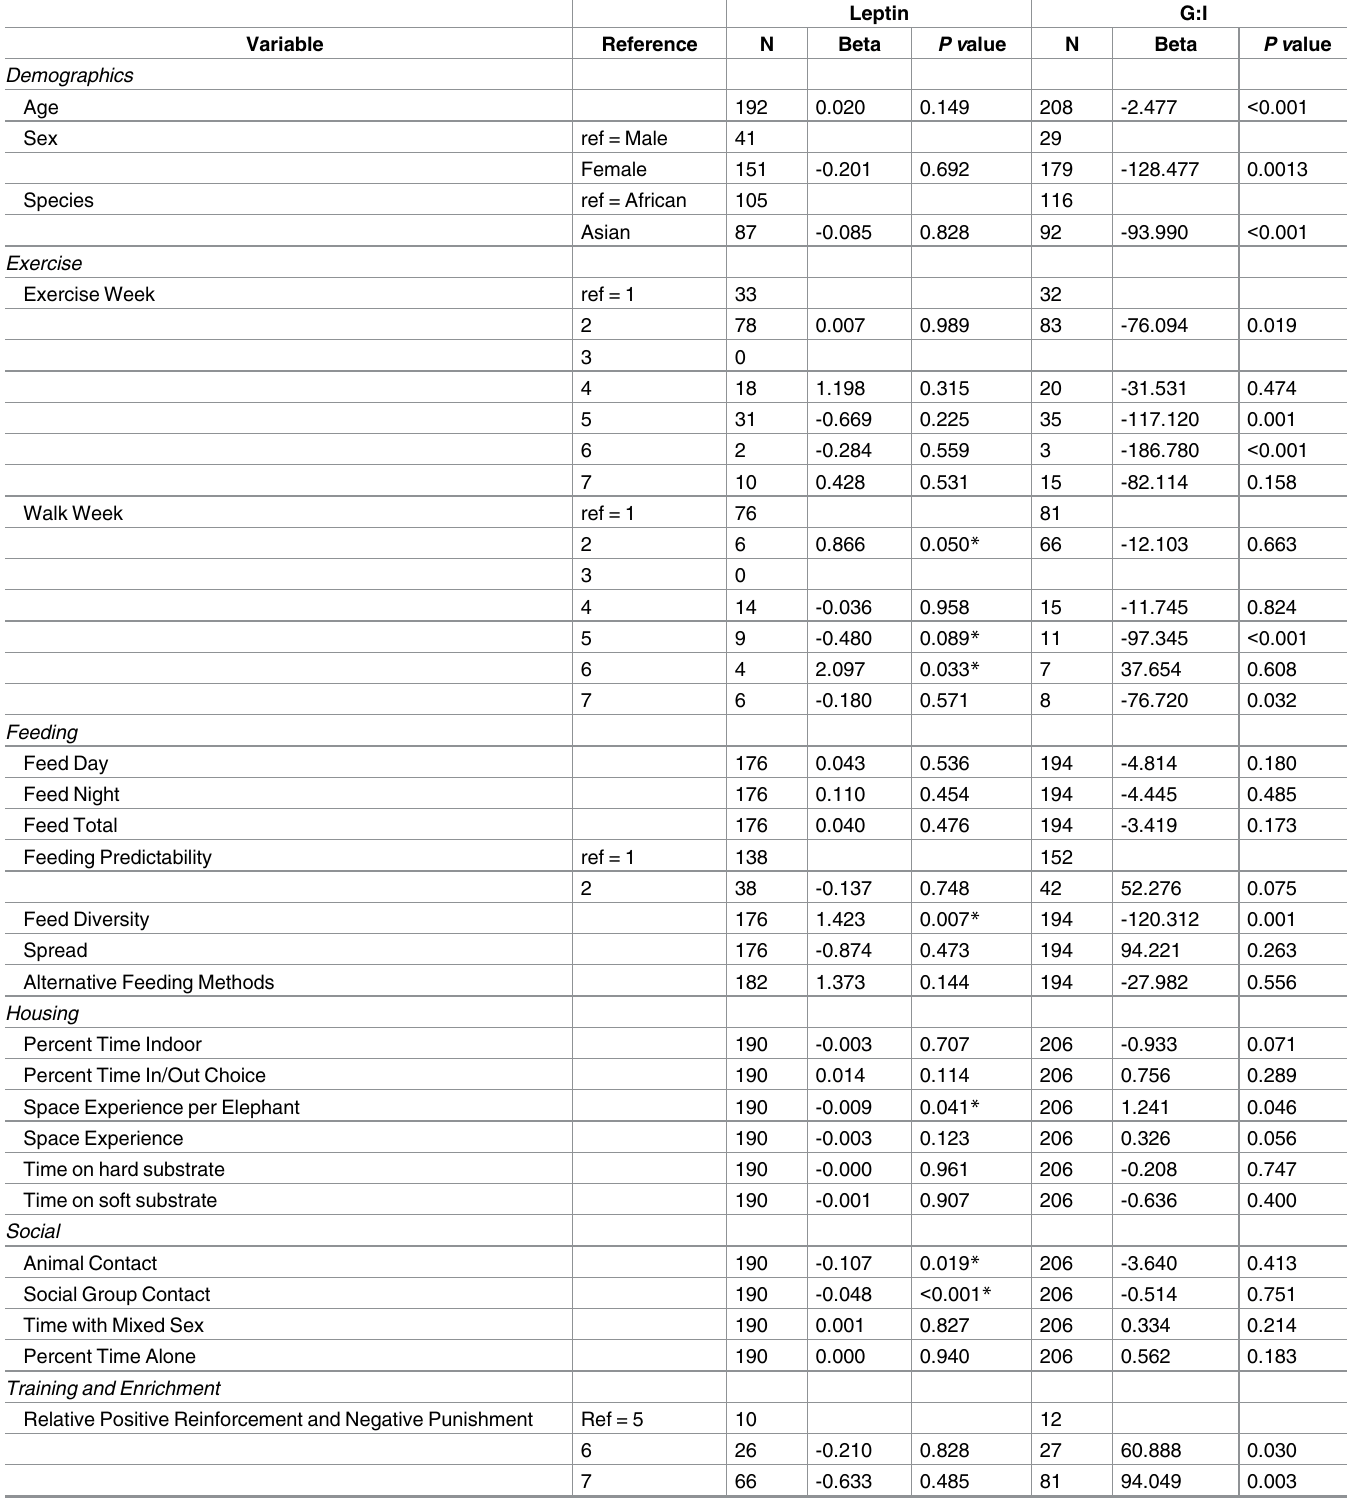
Table 10. Associations between mean leptin levels and the G:I with zoo